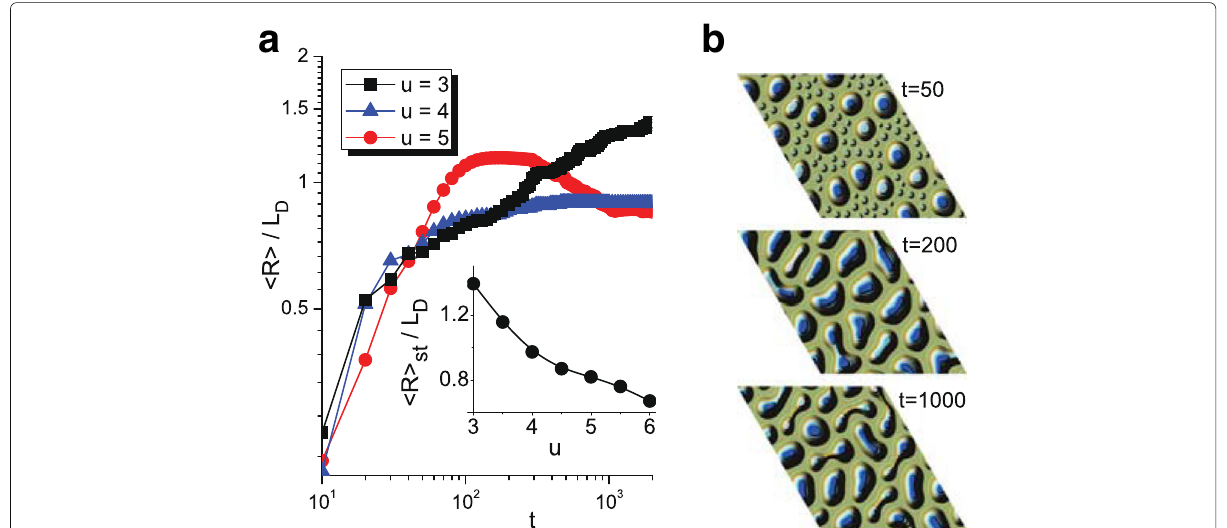
Fig. 3 Evolution of the mean linear size of adsorbate islands (cid:10) R (cid:11) in units of diffusion length L D on a half-height of the growing surface at different values of anisotropy strength u ( a ). Typical snapshots of the system evolution at u = 5 and different time instances ( b